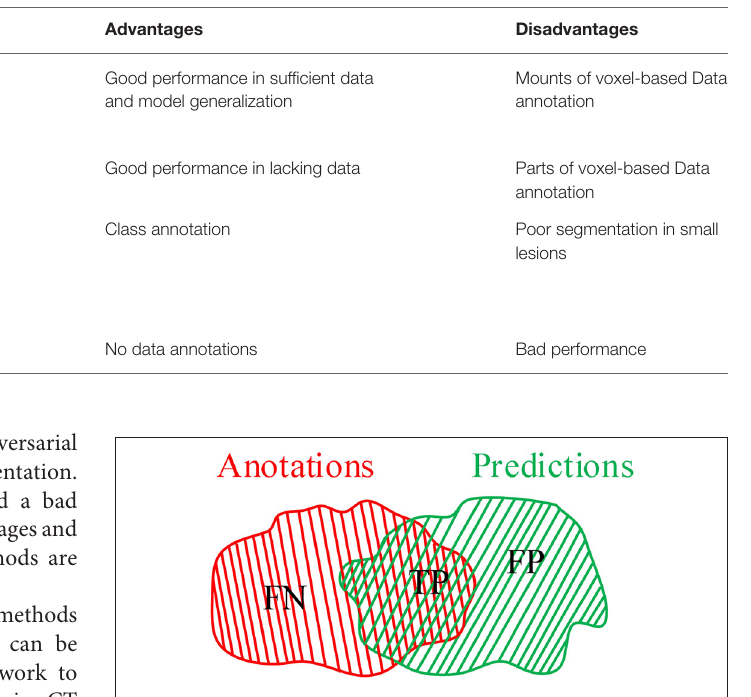
FIGURE 1 | An intersection over union (IoU)